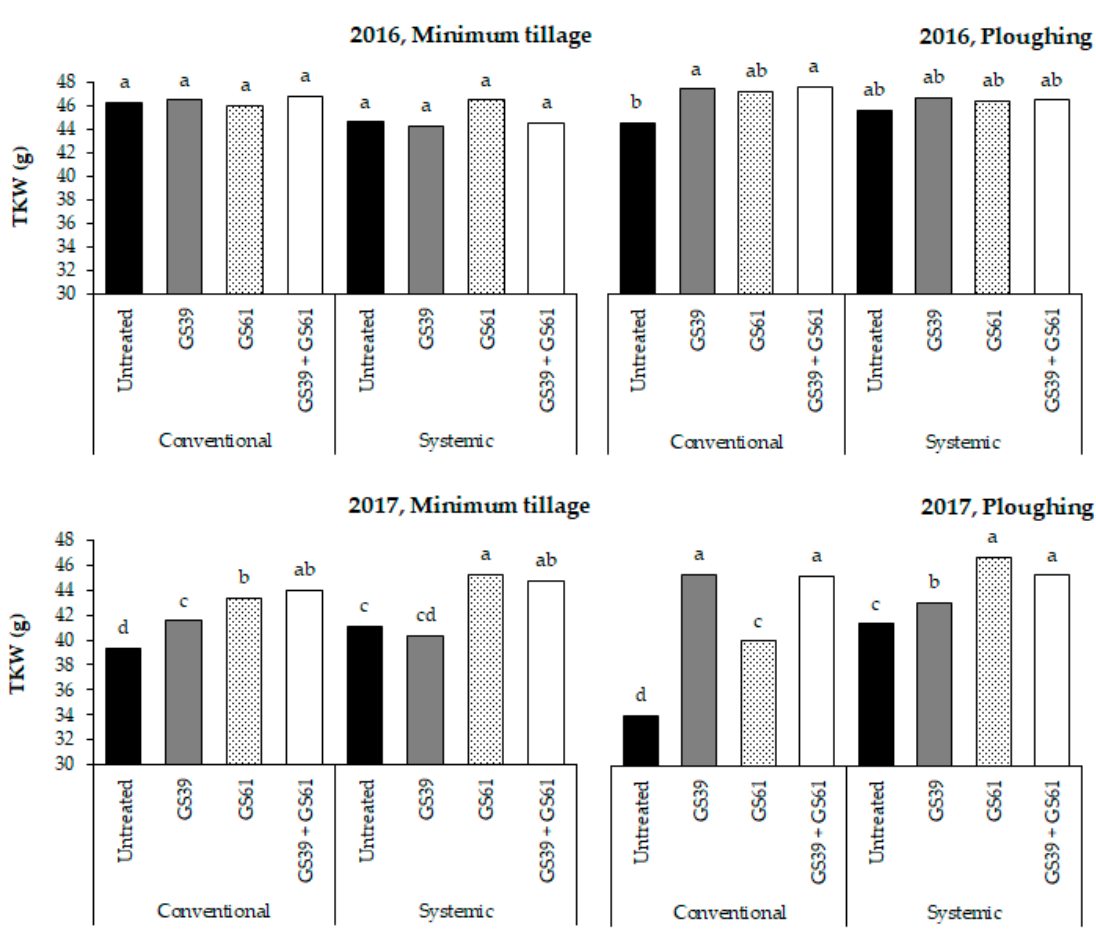
Figure 5. Effect of fungicide seed 1 and foliar 2 treatments on the thousand kernel weight (TKW) under different soil tillage conditions and in different growing seasons (2015–2016 and 2016–2017) in North Italy. The bars in each experiment with different letters are significantly different ( p -value < 0.05), according to the REGW-F test. The reported values are based on 4 replications. 1 Fungicide seed treatments: conventional (fludioxonil AI) and systemic (fluxapyroxad AI); 2 Fungicide foliar treatment: untreated control; GS39, a single treatment at the end of stem elongation (pyraclostrobin + fluxapyroxad AI); GS61, a single treatment at the beginning of flowering (epossiconazole + metconazole AI); GS39 + GS61, a double treatment through a combination of the GS39 and GS61 applications.